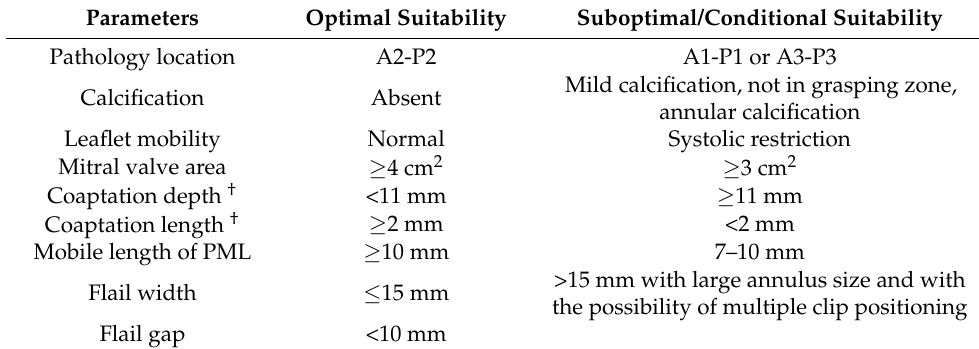
Table 4. Suitability criteria for MitraClip